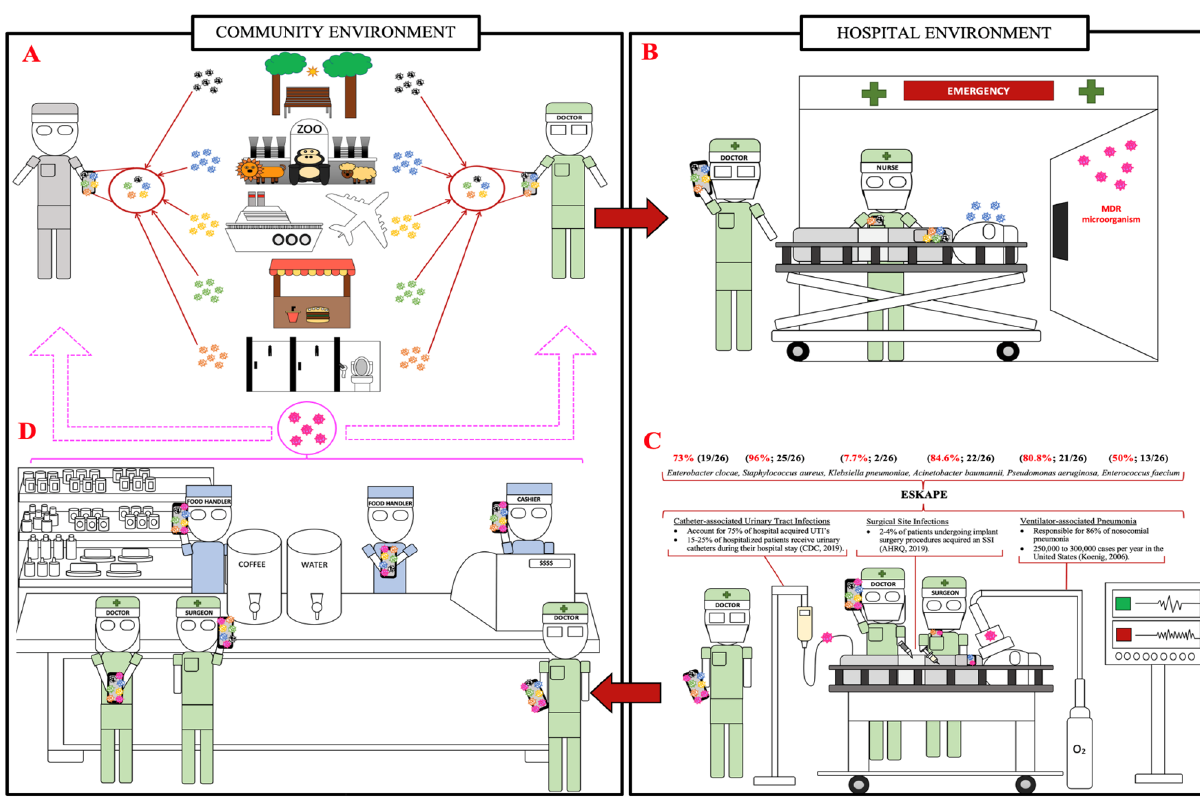
Figure 10. Contaminated mobile phones potential vectors of dissemination of germs in and out healthcare and community